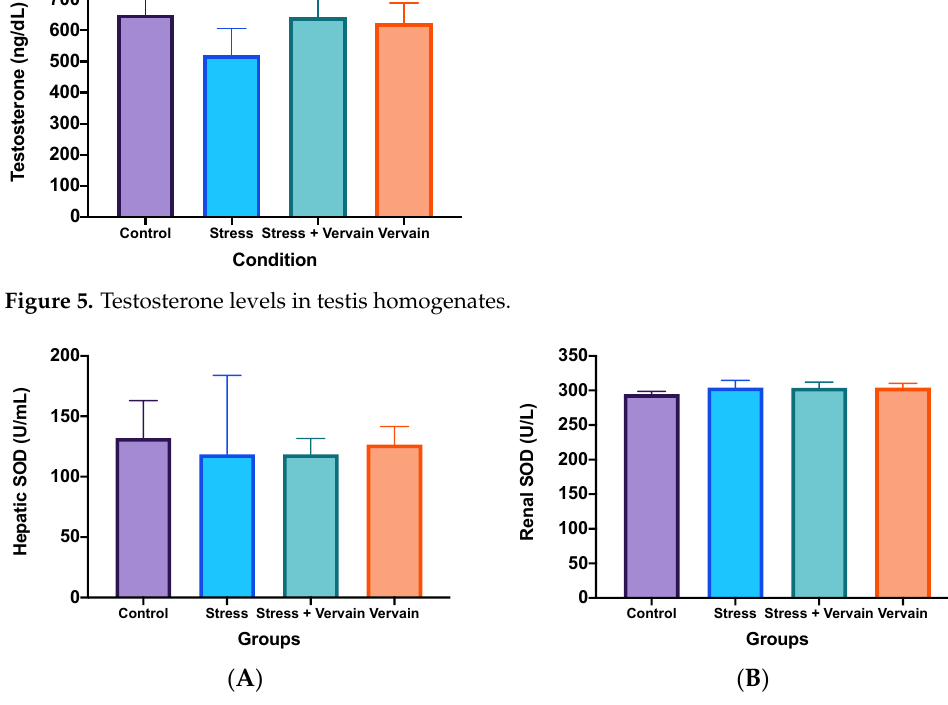
Figure 6. Quantitative determination of superoxide dismutase (SOD) in ( A ) liver and ( B ) kidney. No statistical difference was determined; however, there was more variance in animals submitted to chronic stress, particularly at the hepatic level.